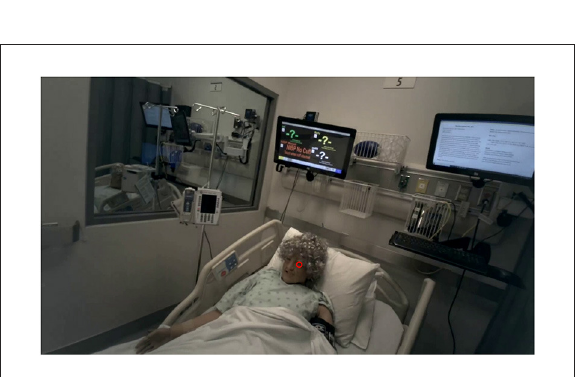
FIGURE8 An example of fixation overlay from Scenario 2 used for manual annotation. In this frame, the resulting AOI is “patient”.